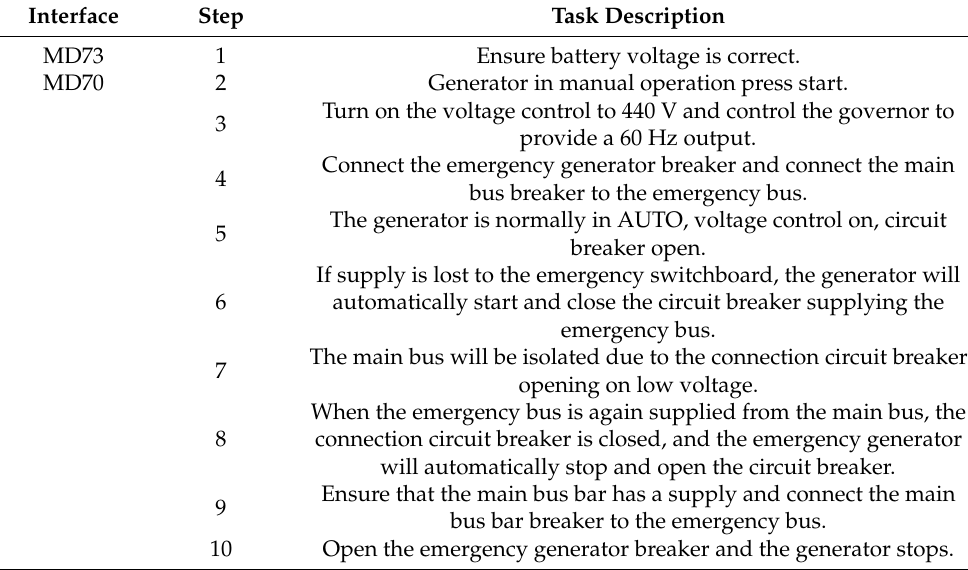
Table 1. The emergency generator operation process.